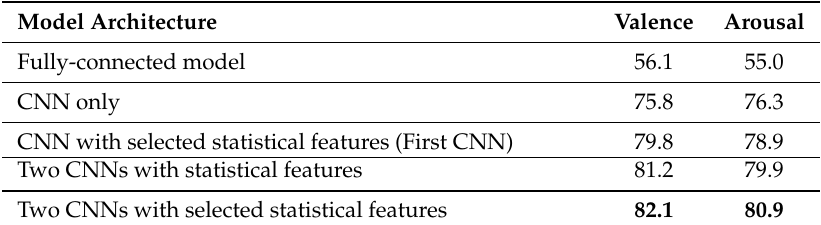
Table 4. Experimental result according to the model architecture.